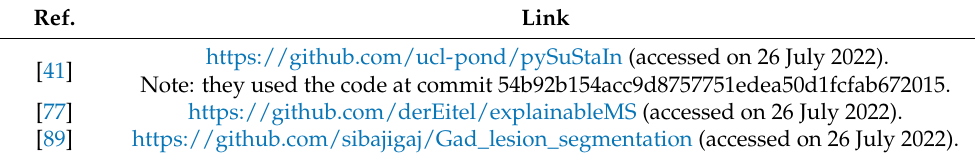
Table 4. Open-source codes weblinks. Ref.